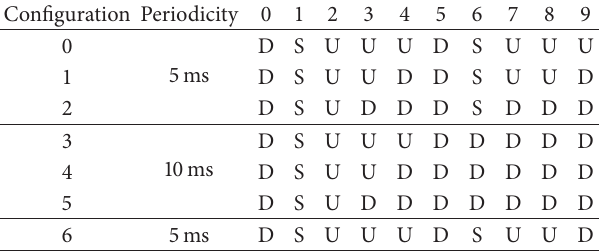
Table 2: TD-LTE DL/UL configuration (D: downlink, U: uplink, S: special subframe).